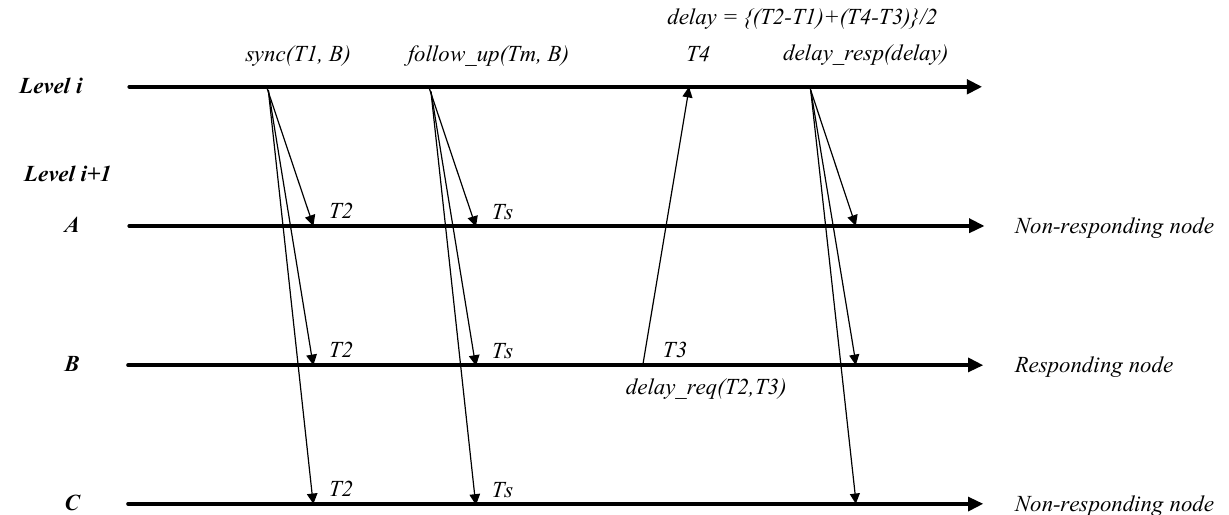
Figure 4. Synchronization protocol for drift correction.